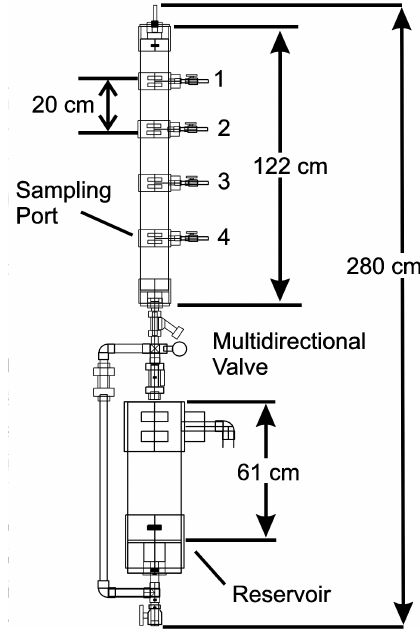
Figure 1. Schematic of the column reactors used in this